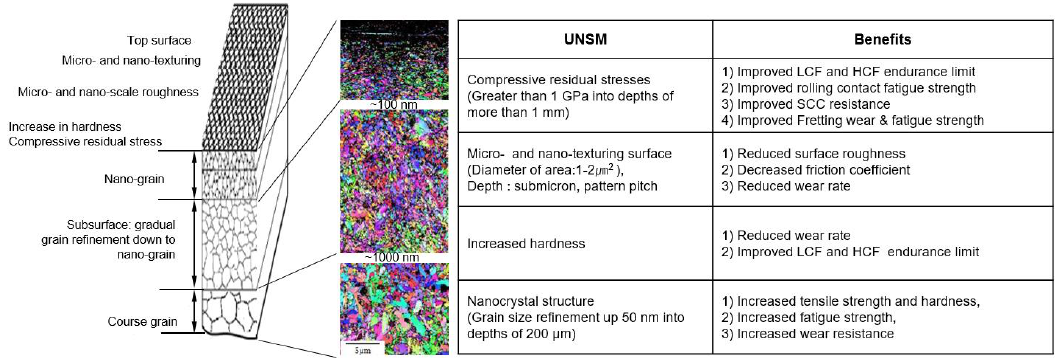
Figure 6. Changes in mechanical properties and microstructure and performance improvement.